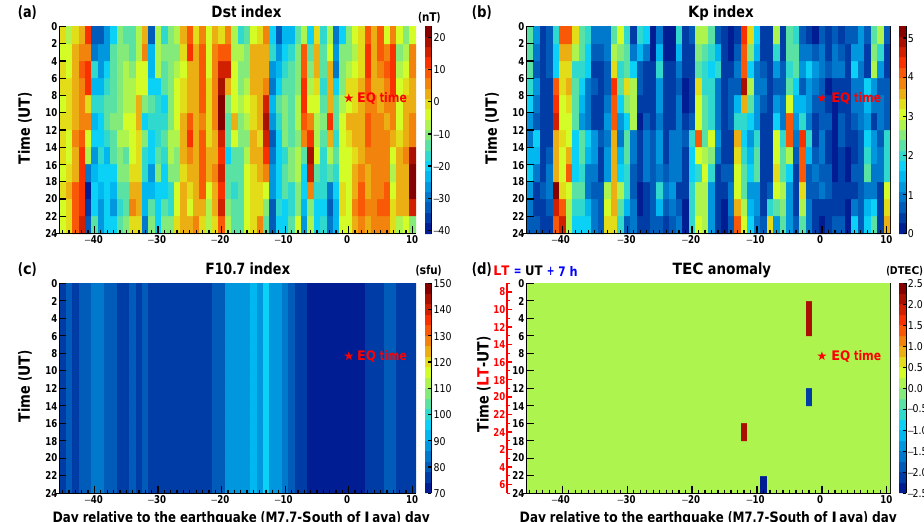
Figure 2. TEC anomaly analysis for the south of Java earthquake (17 July 2006) from 2 June to 27 July 2006. The earthquake time is represented by a red star. The x axis represents the day relative to the earthquake day. The y axis represents the UT (LT = UT + 7h). (a) Dst geomagnetic index. (b) Kp geomagnetic index. (c) Solar radio flux F10.7 index. (d) TEC anomaly detected under the following conditions: Dst > − 30nT, Kp < 3, F10.7 < 100sfu and | DTEC | > 2 . 0. Here 1TECU = 10 16 electronsm − 2 .